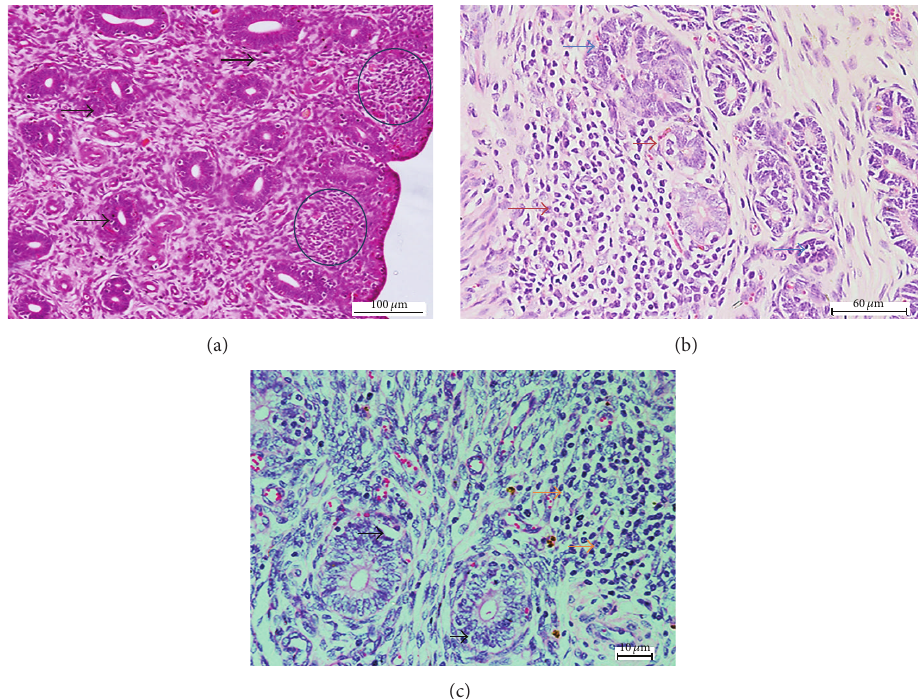
Figure 2: Photomicrograph section of the uterus of nonpregnant does inoculated with Corynebacterium pseudotuberculosis. Note (a) the inflammatory and necrotic cells (brown arrows), degeneration of endometrial glandular epithelium (blue arrows), following intranasal inoculation; (b) degeneration of endometrial glandular cells (black arrows), inflammatory cells (orange arrow), following oral inoculation; (c) inflammatory cells in the submucosa (blue circle), degeneration and necrosis of endometrial glandular epithelium (black arrow), following intradermal inoculation (H&E × 200).